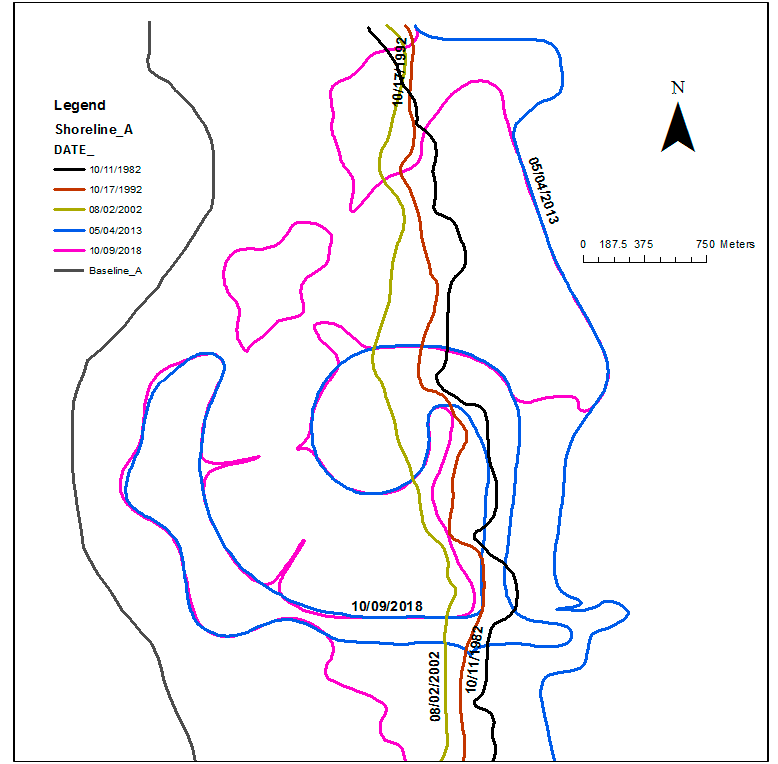
Figure 9. Northern part of Lusail City.